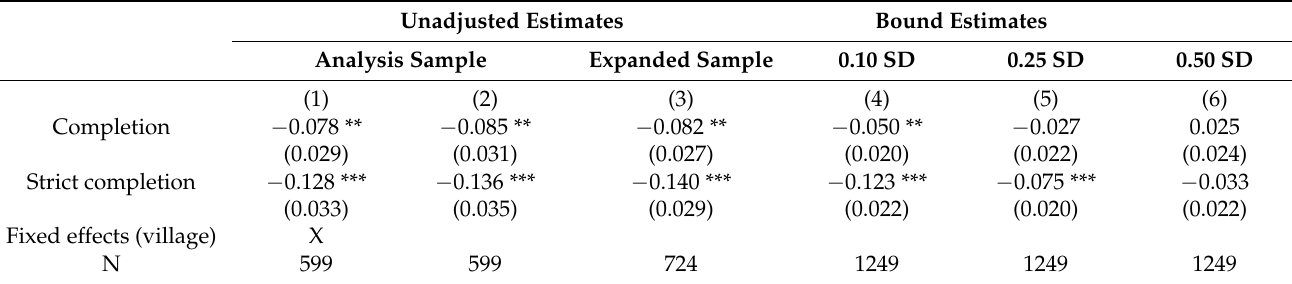
Table 7. Sensitivity